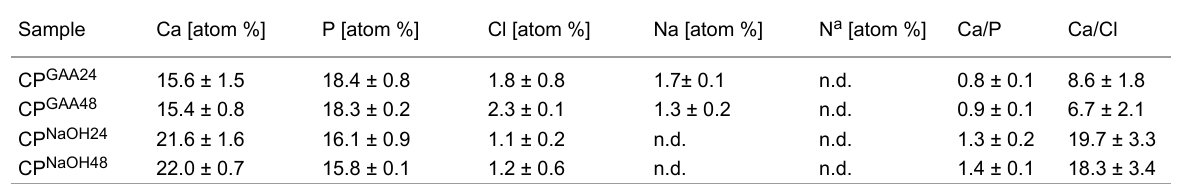
Table 2: EDXS data of the precipitates; n.d. = not detected. EDXS does not observe any nitrogen indicative of the ionic liquid. Elemental analysis (EA) finds ca. 1% of carbon. Nitrogen is below the detection limit of the EA instrument